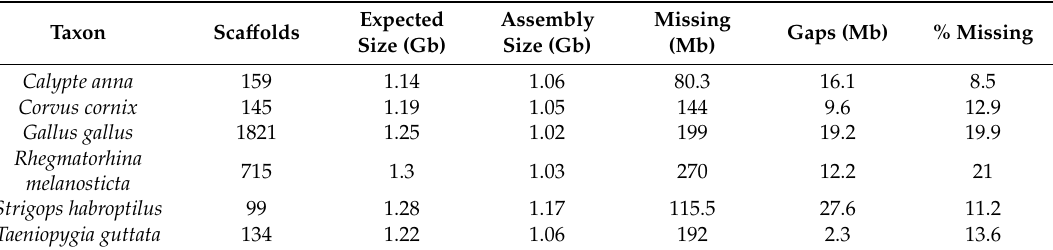
Table 3. Comparison of the Rhegmatorhina melanosticta linked-read de novo assembly with PacBio long-read bird assemblies. Expected genome size is based on chromosome density from flow cytometry (from [76,77,90]). Missing (Mb) is an estimate of unsequenced genome (expected assembly size subtracted from the assembly size [76]). Gaps is the total number of “N”s in the assembly. The percentage of missing sequence is the sum of unsequenced genome and gap length relative to